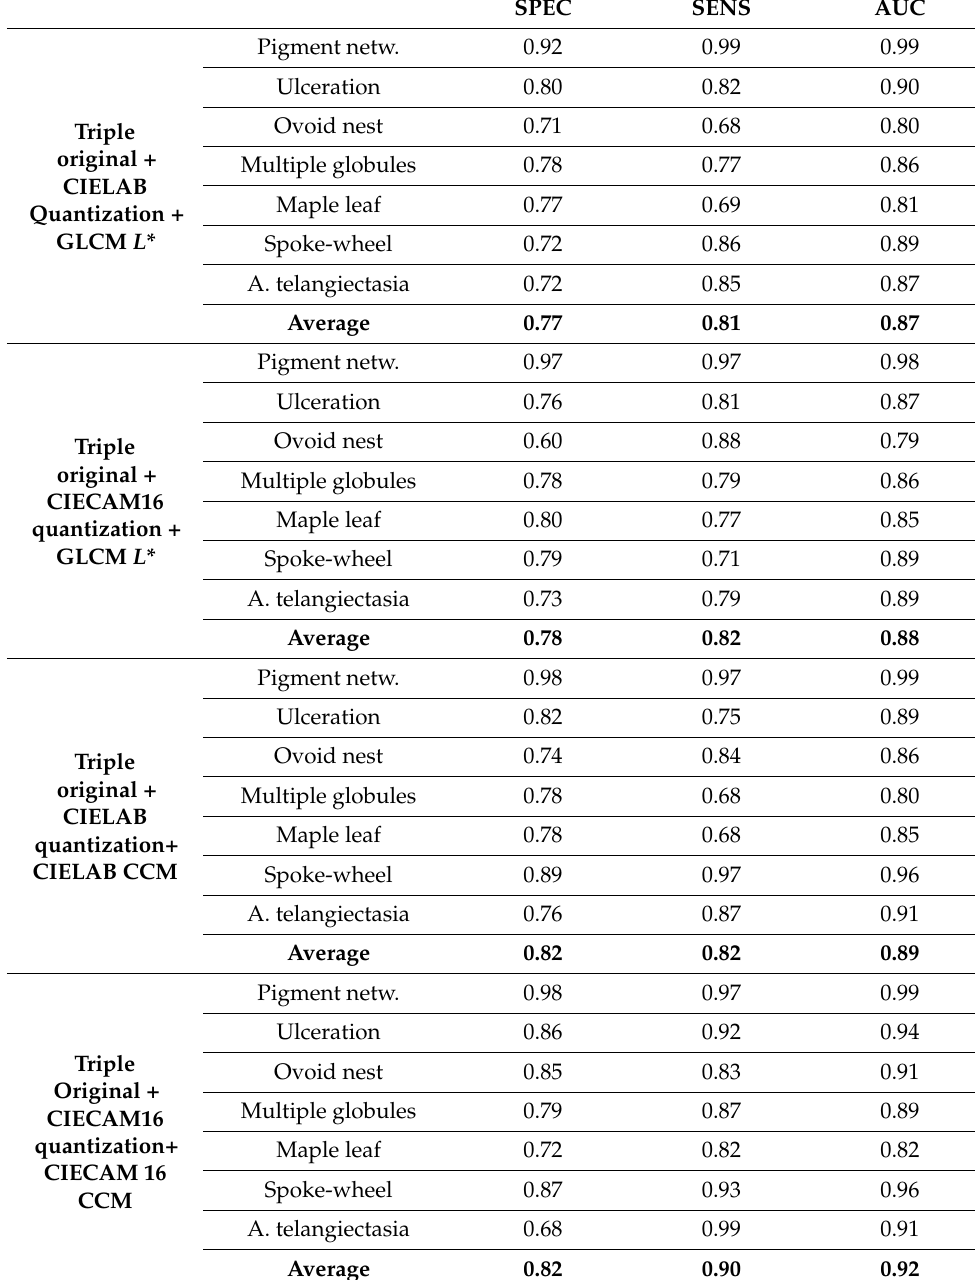
Table 3. Evaluation results for Test 3 classification SPEC: specificity; SENS: sensitivity; AUC: area under the